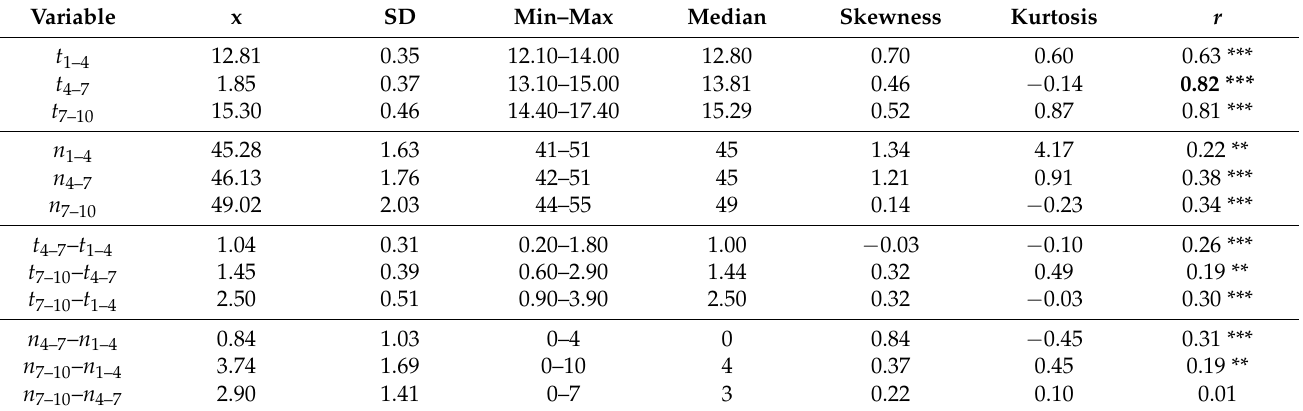
Table 5. Descriptive statistics of hurdle variable addition and differences (temporal and